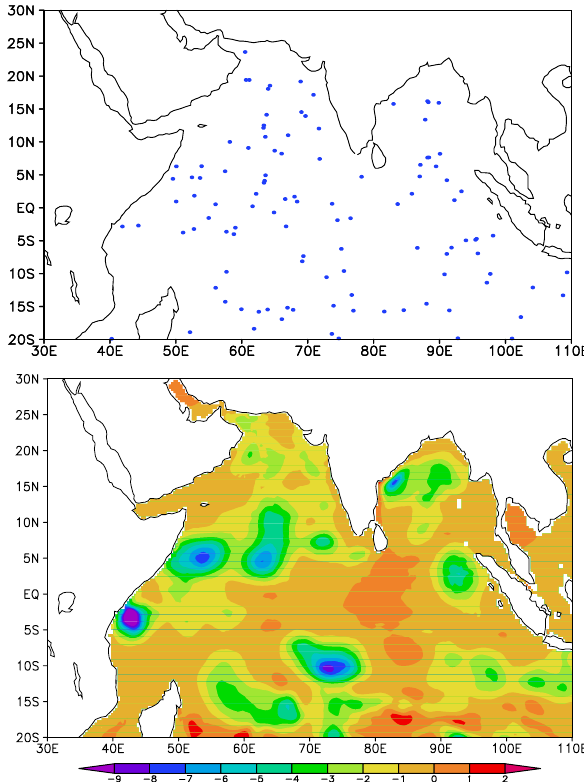
Figure 8 Figure 8. The distribution of Argo floats used in the assimilation (top) and the difference between the SSH (sea surface height) from the Argo assimilation experiment and SSH from the CTRL without any data assimilation (bottom; unit: